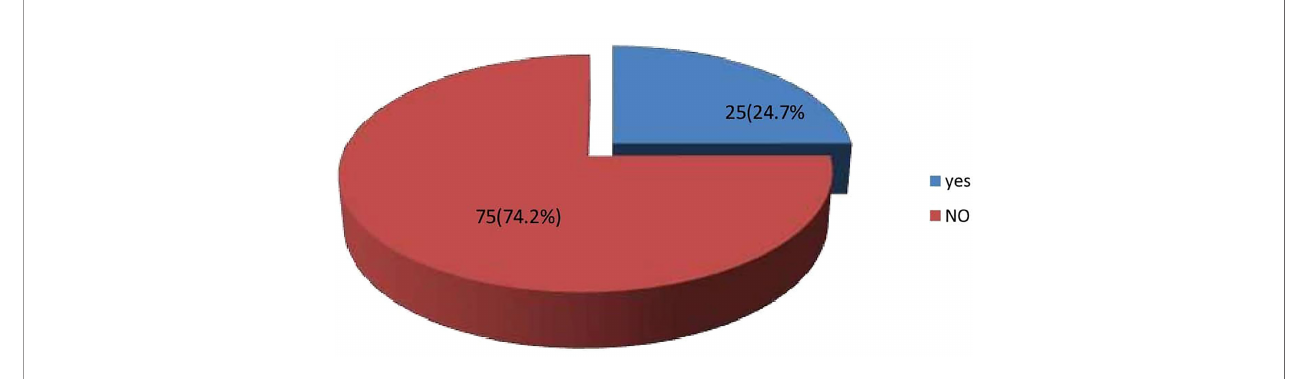
FIGURE 2 | Frequency of Amputation.